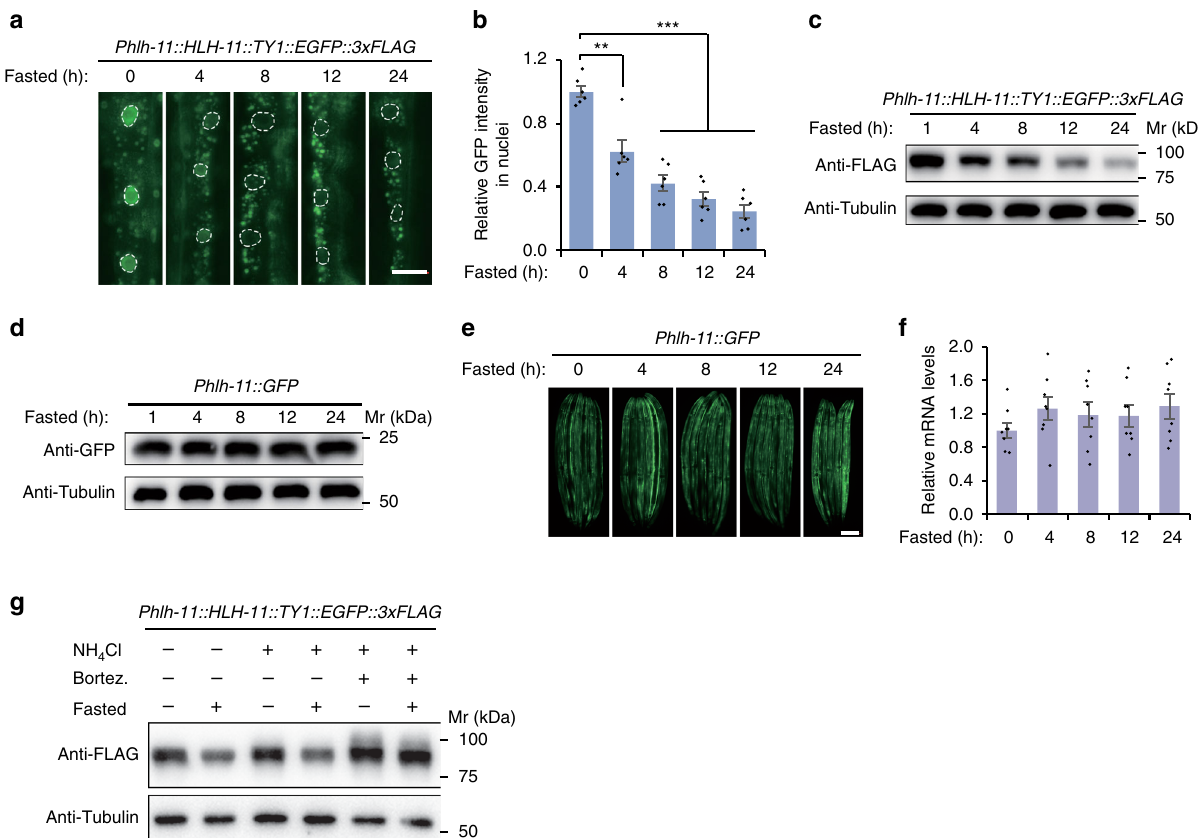
Fig. 5 HLH-11 protein degradation occurs in response to starvation. a Representative fl uorescence images showing upper intestines of worms expressing Phlh-11::HLH-11::TY1::EGFP::3xFLAG fasted for the indicated time period. Three independent experiments were performed with similar results. Scale bar, 20 μ m. b Quanti fi cation of nuclear GFP intensity of worms fasted in a . Six nuclei were measured under each condition. ** p = 0.0013 (4 vs 0 h); *** p = 5.3E − 6 (8 vs 0 h), *** p = 4.5E − 7 (12 vs 0 h), *** p = 1.3E − 7 (24 vs 0 h). c Representative immunoblotting images showing the protein levels of HLH-11 and Tubulin (loading control) in Phlh-11::HLH-11::TY1::EGFP::3xFLAG worms fasted for the indicated period of time. Three independent experiments were performed with similar results. d Representative immunoblotting images showing the protein levels of GFP and Tubulin (loading control) in Phlh-11::GFP worms fasted for the indicated period of time. Three independent experiments were performed with similar results. e Representative fl uorescence images of Phlh-11::GFP worms fasted for the indicated time period. n = 5 – 6 worms per condition. Three independent experiments were performed with similar results. Scale bar, 100 μ m. f qPCR analyses of endogenous hlh-11 transcript levels in wild-type worms fasted for the indicated period of time. n = 8 biologically independent samples. g Representative immunoblotting images showing the protein levels of HLH-11 and Tubulin (loading control) in worms treated with or without the proteasome inhibitor Bortezomib (5 μ g/ml) or the lysosome inhibitor NH 4 Cl (200 mM). Three independent experiments were performed with similar results. Error bars indicate mean ± SEM. Statistical analyses were performed by Student ’ s t test (unpaired, two tailed), ** p < 0.01; *** p < 0.001. Source data are provided as a Source data fi